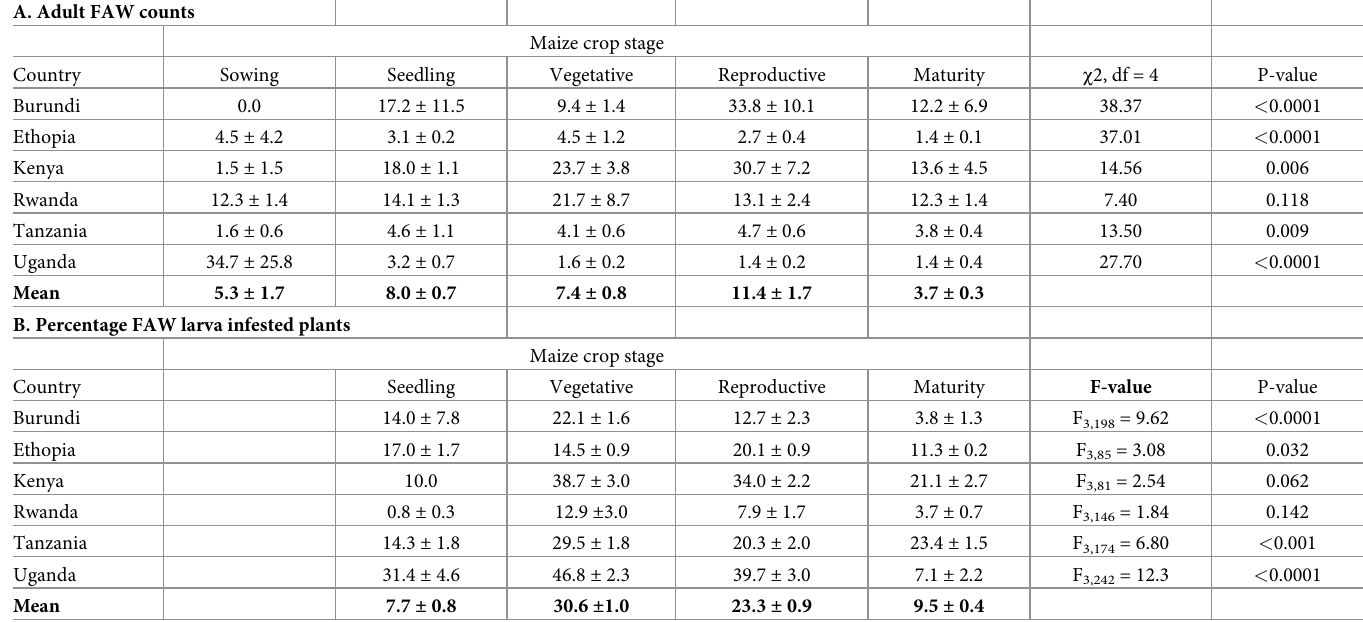
The mapping of total FAW adults and larvae counts collected, indicated a clear progression over time of the infestation across East Africa (Fig 9). The figures in the legend represent the Table 4. Mean ( ± SE) adult FAW abundance (A) and mean ( ± SE) percentage FAW larva infested plants (Scounted larva) (B) for each country across maize crop stage and the corresponding test statistics for the Negative binomial model for adult FAW abundance and for the quasi-binomial model for percentage larva infested